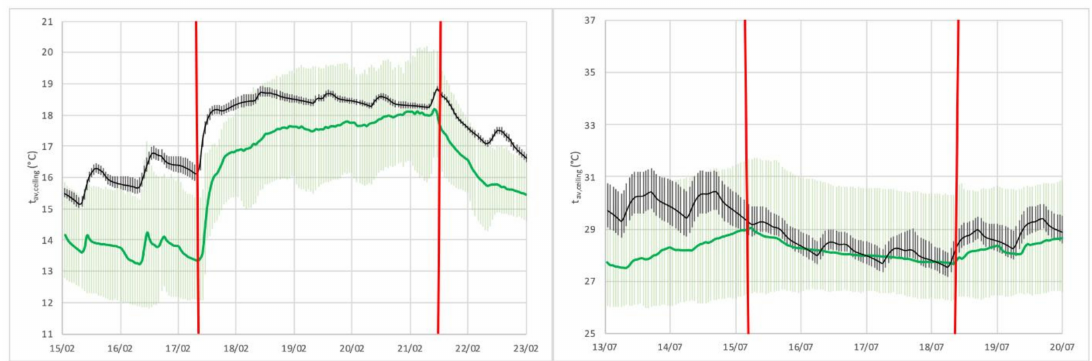
Figure 10. Comparison between Scenario #1 (green lines) and Scenario #2 (black lines) for winter (left) and summer (right)